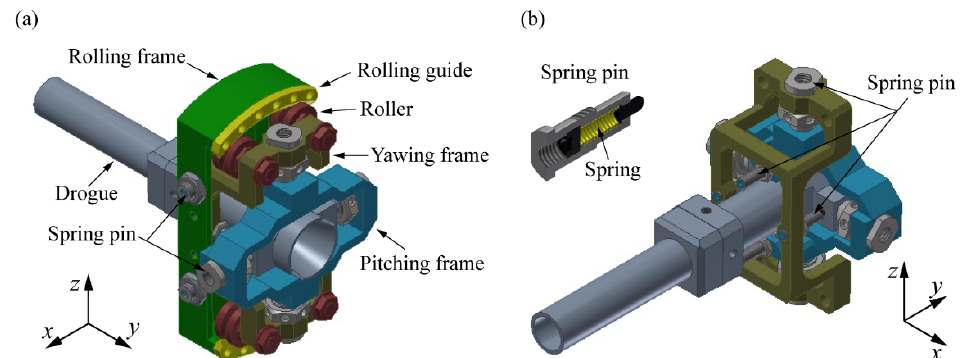
Figure 4. Components of the passive alignment subassembly: ( a ) forward isometric drawing, ( b ) reversed isometric drawing. Table 1. Basic information of the docking mechanism